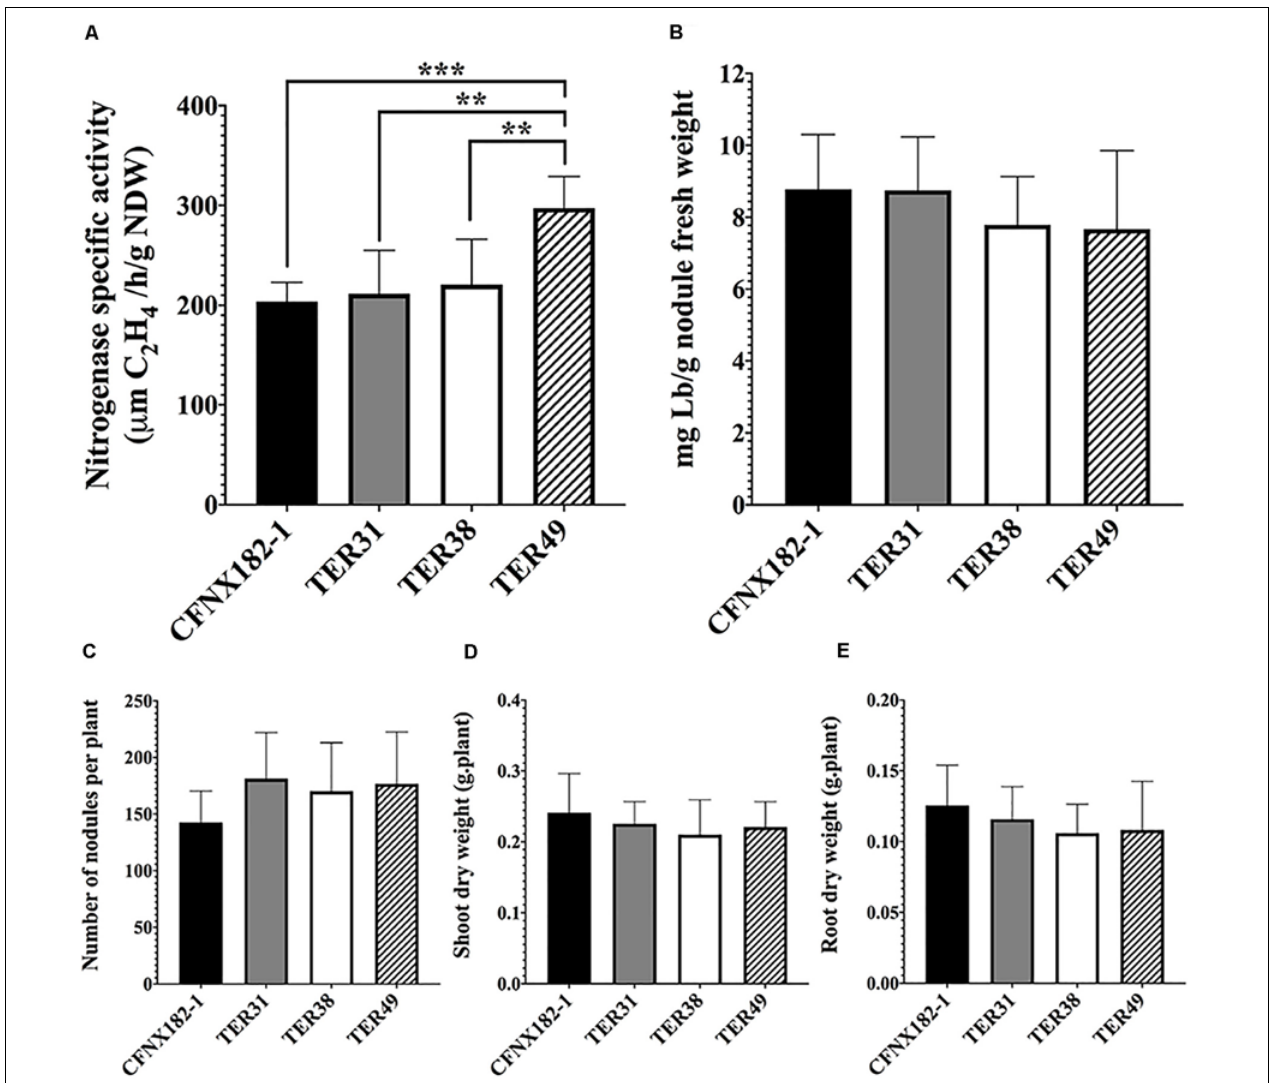
FIGURE 3 | Symbiotic performance of TER strains with P. vulgaris . Bean plants were inoculated with the different strains, after 21 dpi symbiotic performance was analyzed by: (A) nitrogenase-specific activity by ARA, (B) leghemoglobin content, (C) number of nodules per plant, (D) shoot dry weight, and (E) root dry weight. Strains: CFNX182-1 (black bars), TER31 (gray bars), TER38 (white bars), and TER49 (striped bars). A t- test ( P < 0.05), was used to determine statistically significant differences in the nitrogenase specific activity in (A) . 0.0021 (**), 0.0001 (****).